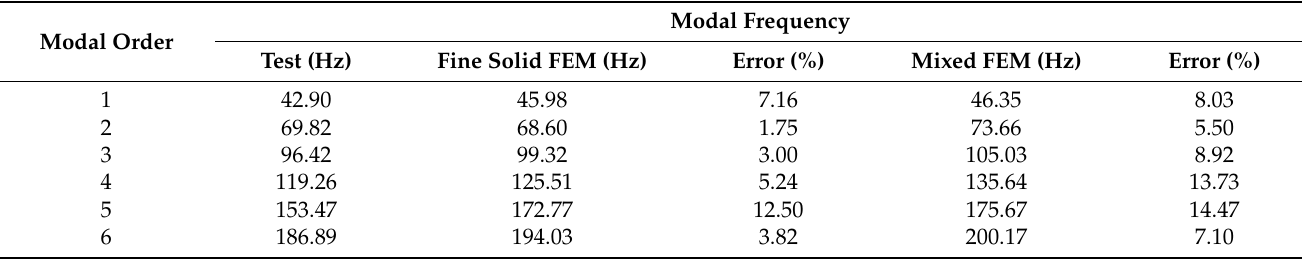
Table 2. Frequency correlation analysis